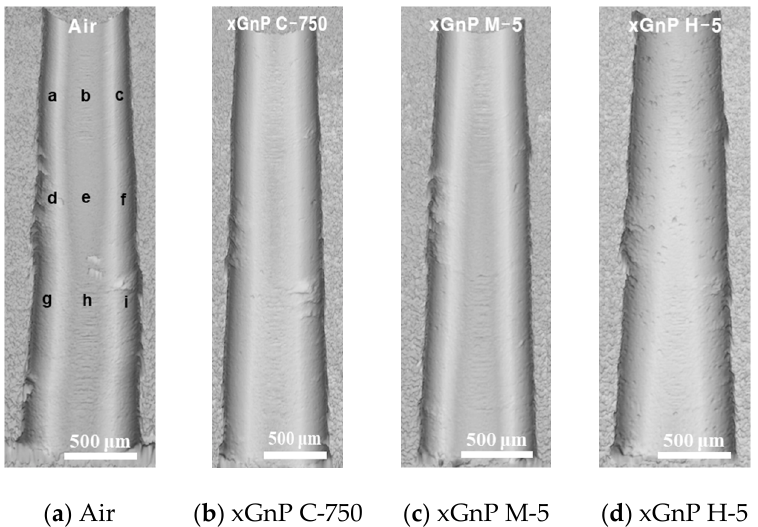
Figure 14. 3D profiles of the 90th drilled hole and the nine sectors ([a]–[i])